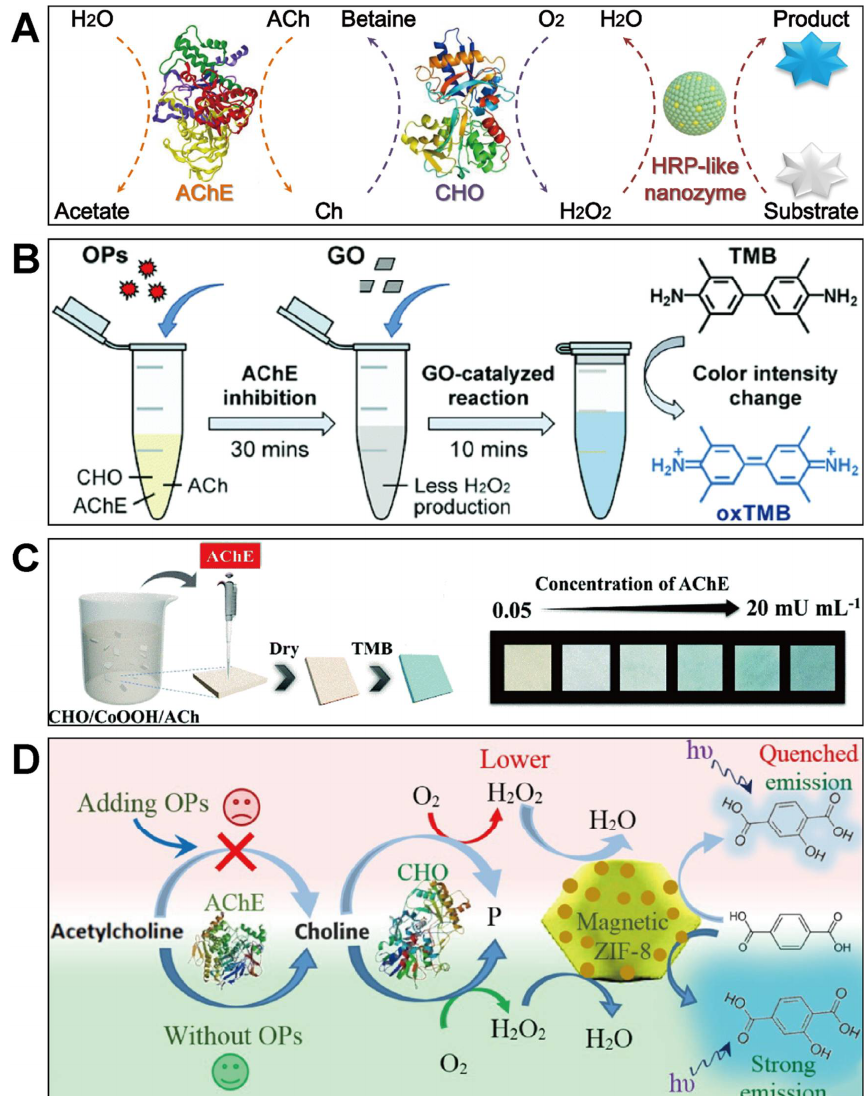
Figure 2. ( A ) illustrates detection principle of pesticides and cholinesterases based on ternary AChE−CHO−nanozyme cascade catalytic reactions. ( B ) shows colorimetric analysis of OPs via an AChE-CHO-GO cascade system (Reprinted with permission from [49], Copyright 2020, Royal Society of Chemistry). ( C ) depicts fabrication of an AChE-CHO-CoOOH paper sensor for AChE activity determination (Reprinted with permission from [50], Copyright 2019, Royal Society of Chemistry). ( D ) depicts fluorescence detection of OPs based on an AChE-CHO-nanozyme assay (Reprinted with permission from [52], Copyright 2019, Elsevier).